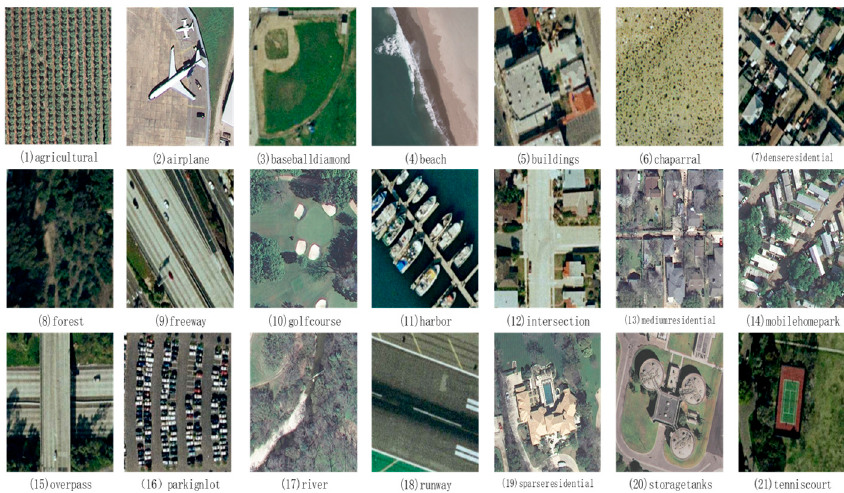
Figure 4. Sample images of UCMD dataset.